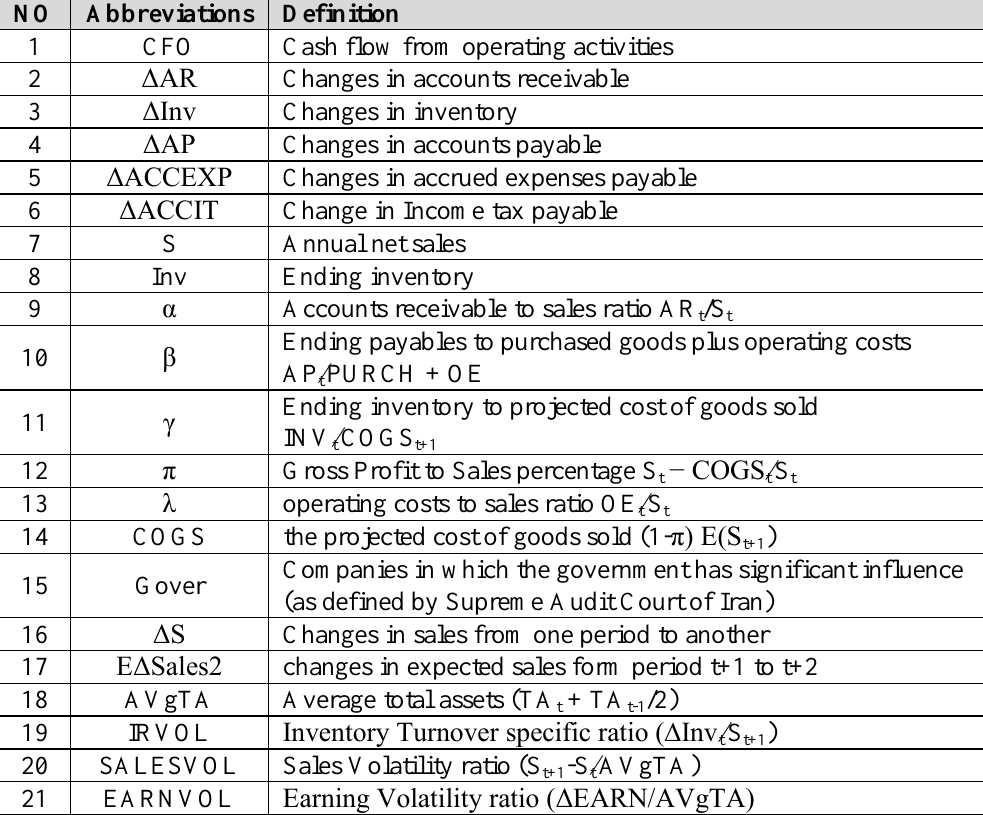
Table2. Variables used in the